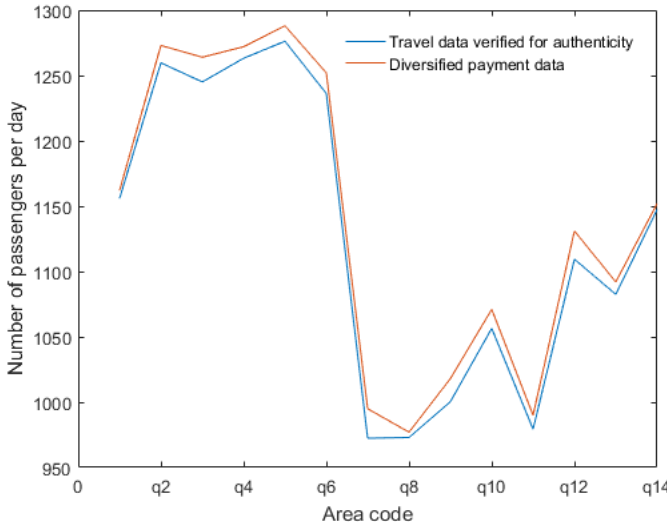
Figure 8. Comparison of statistical data in major bus areas (daily average).